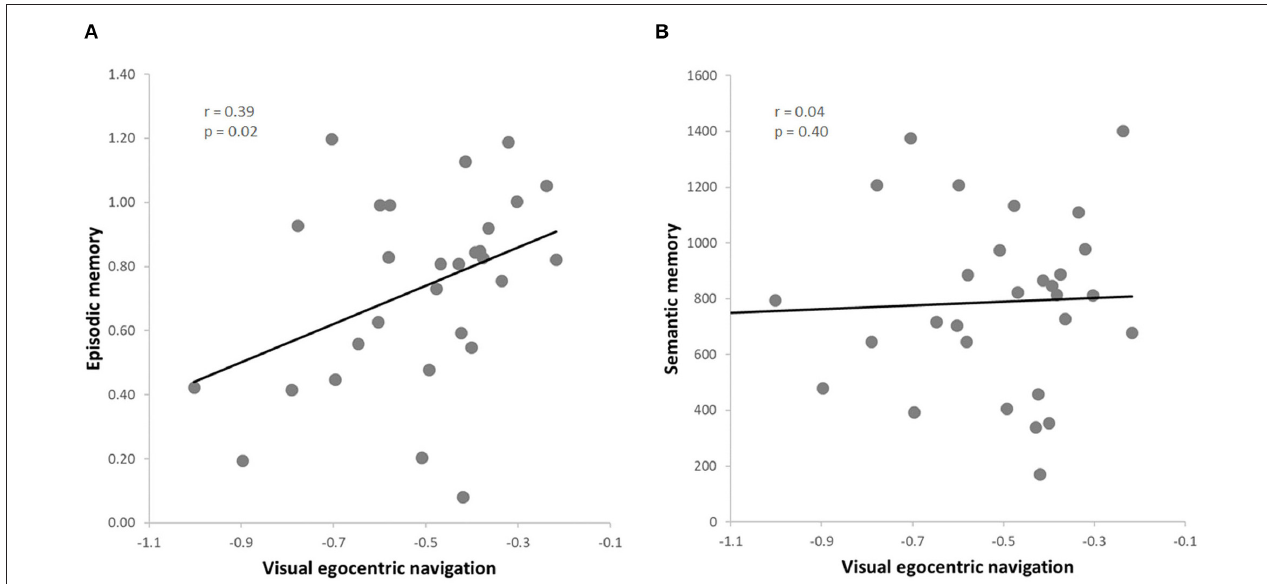
FIGURE 3 | (A) Skipped correlation between visual egocentric navigation (vTCT) and episodic memory (PRT); (B) Skipped correlation between visual egocentric navigation (vTCT) and verbal semantic memory (GKW).